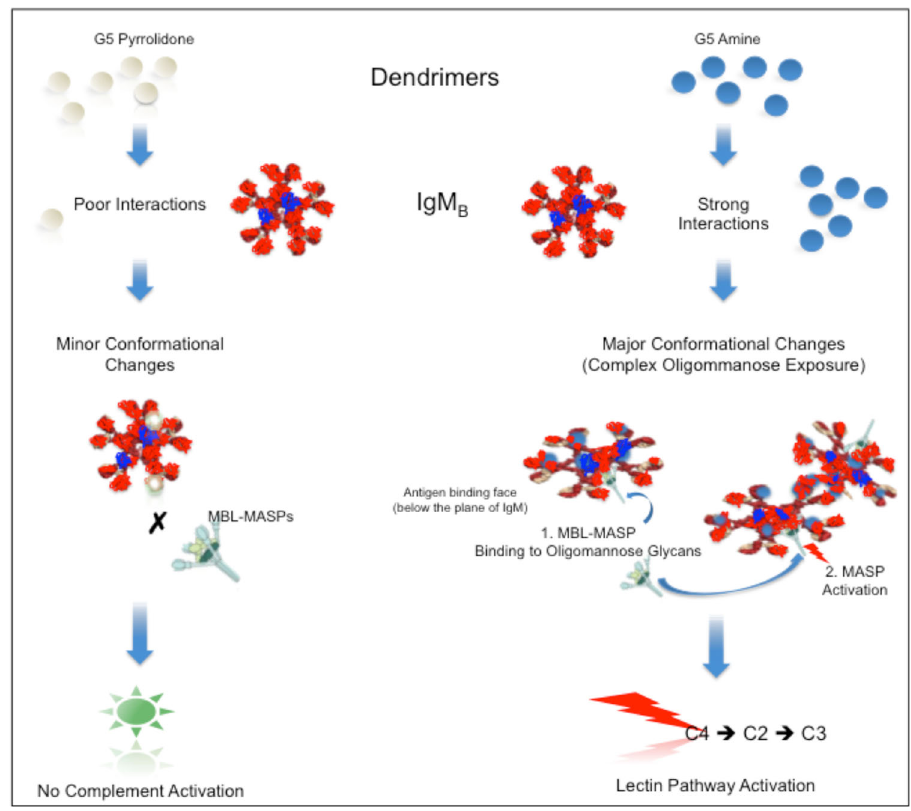
Fig. 4 A proposed scheme for activation of the lectin pathway by dendrimer-IgM B complexes. G5 dendrimers were chosen as example. Pyrrolidone- terminated dendrimers poorly bind to IgM B and on binding do not induce signi fi cant conformational changes in the immunoglobulin structure to promote MBL-MASPs binding. Amine-terminated dendrimers bind to IgM in numbers (and might also promote complex formation with other plasma proteins). This induces conformational changes in IgM and exposes complex oligomannose glycans on the antigen-binding face of the immunoglobulin, thereby allowing MBL binding to complex oligomannose glycans. On MBL binding, MBL activates its MBL-associated serine proteases (MASPs), which, in turn, cleave C4 and C2 to form the lectin pathway C3